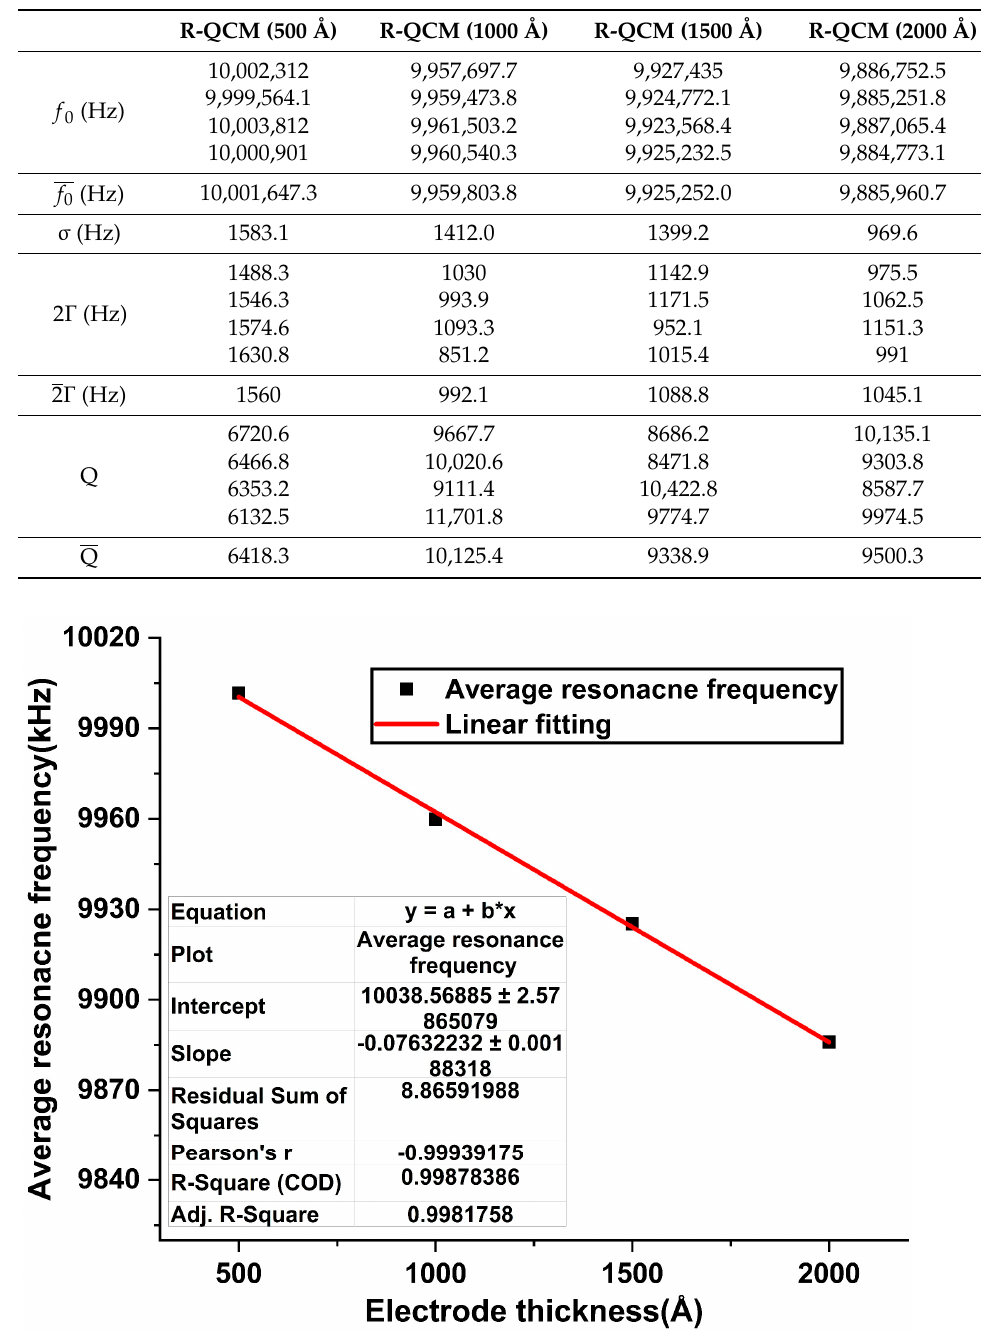
Figure 4. The relationship between resonance frequency of R-QCM and electrode thickness.